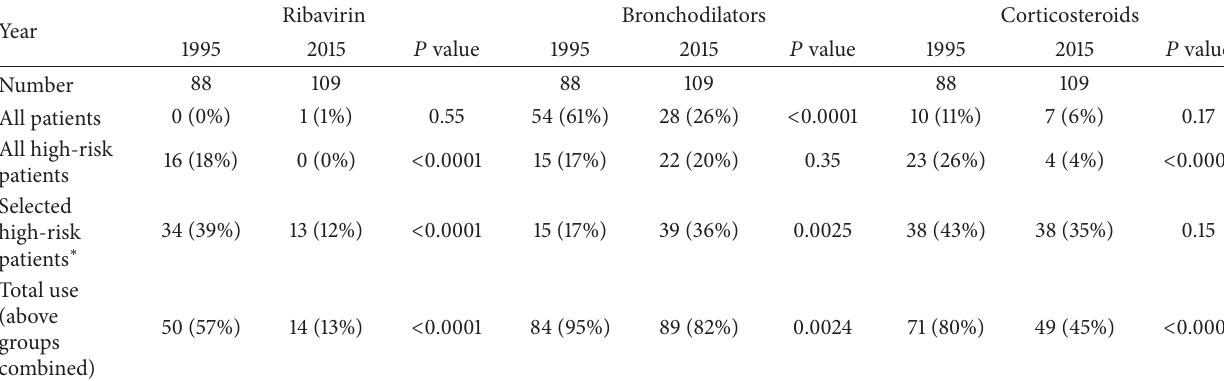
Table 3: Comparison of the use of ribavirin, bronchodilators, and corticosteroids in 1995 with